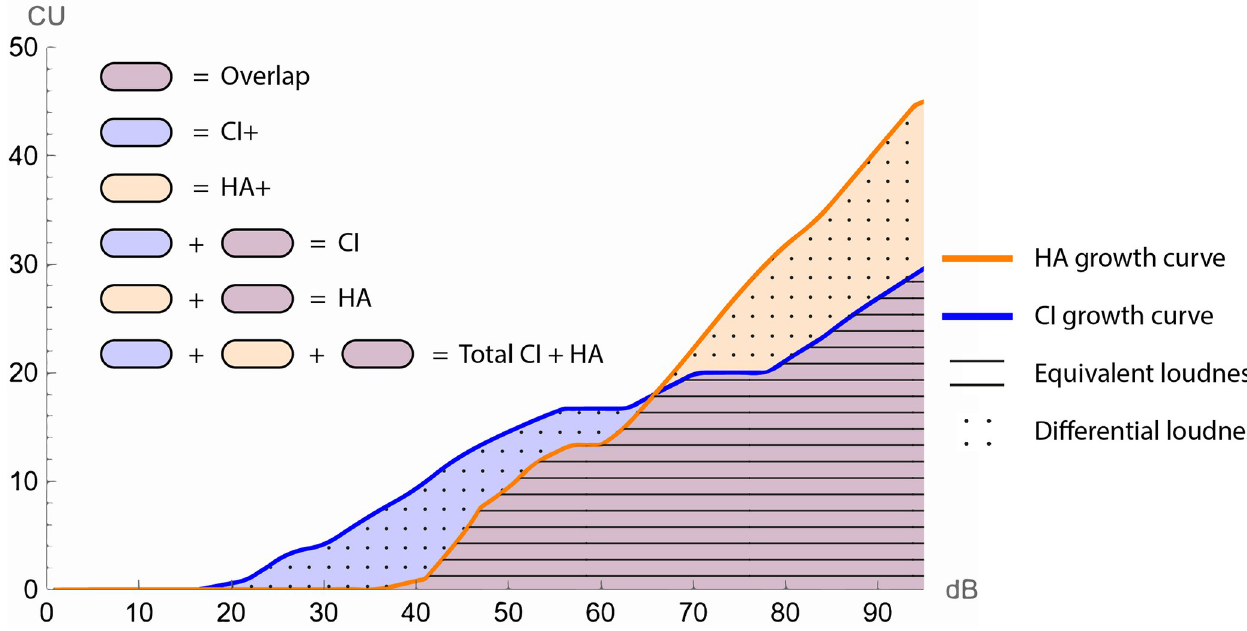
Fig 2. Graph illustrating unilaterally measured loudness growth curves of CI and HA showing the different properties of loudness information that were evaluated in this study.